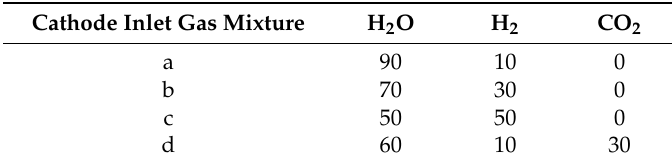
Table 3. Volume percentage composition of cathode inlet